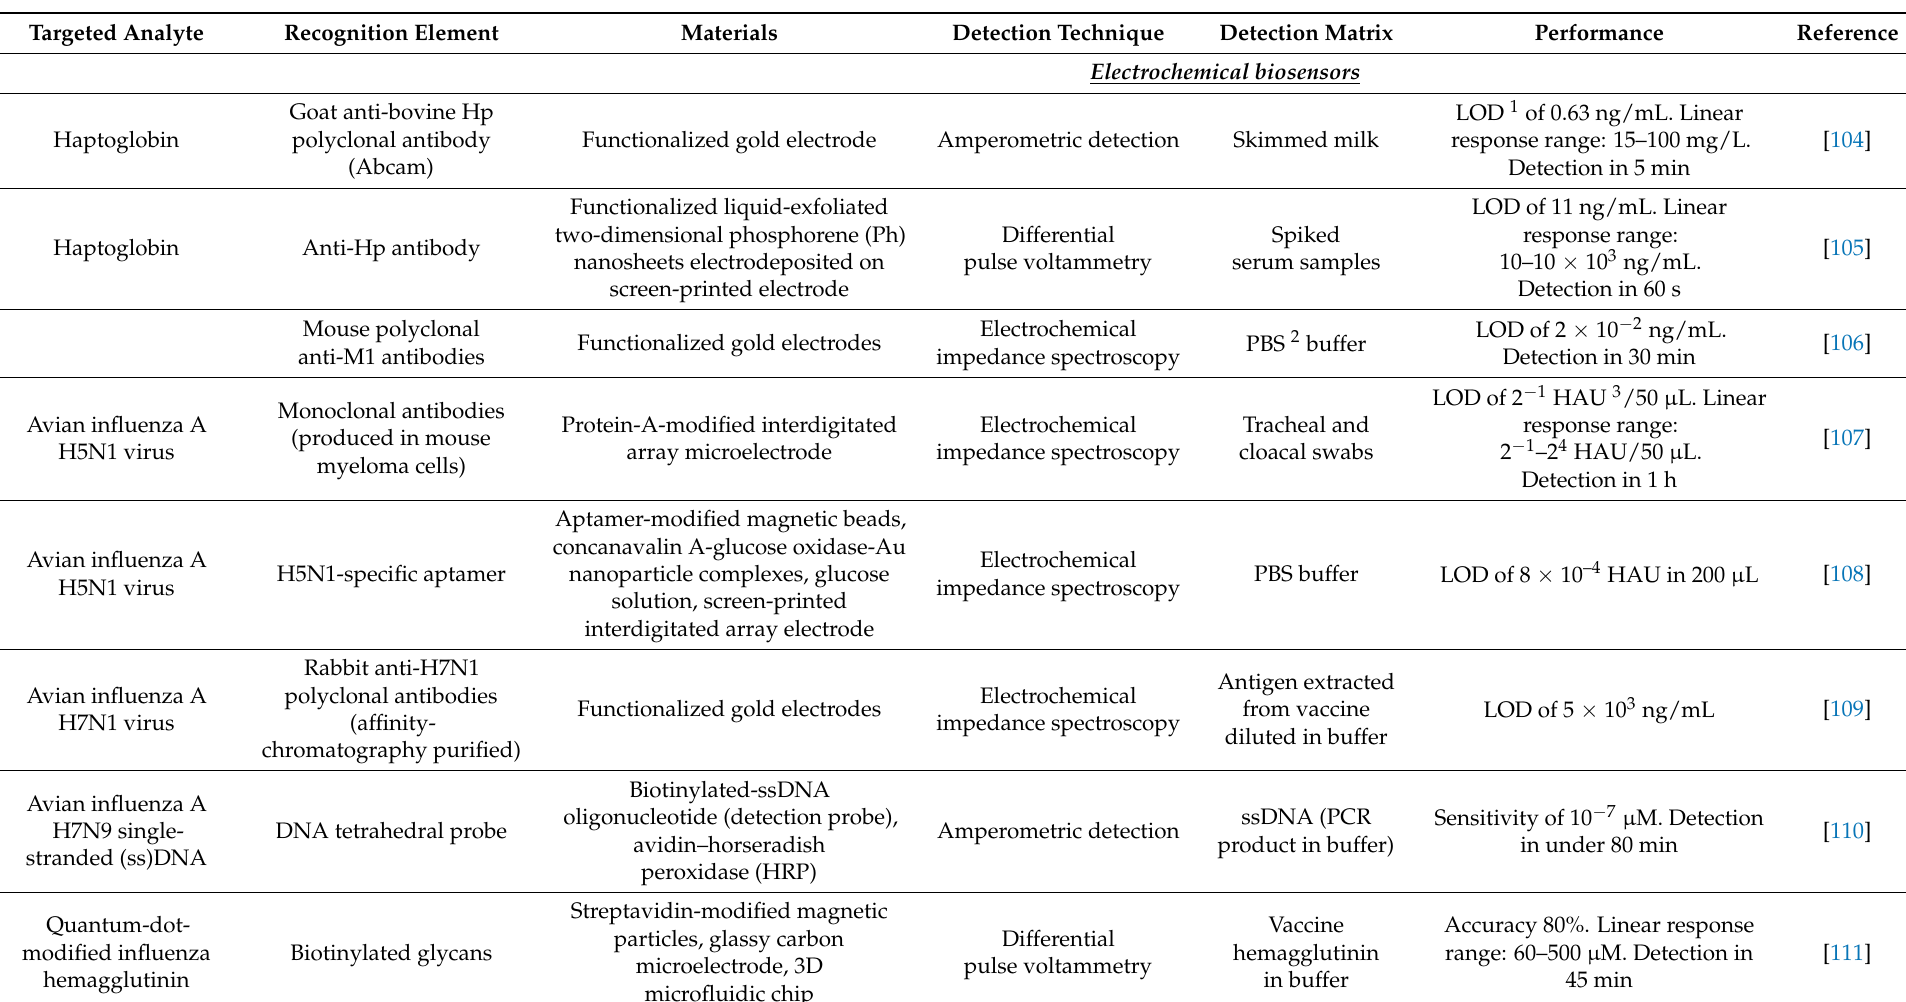
Table 1. Available electrochemical and optical biosensors for the detection of mastitis and animal diseases. The available literature for the remaining transducing options is included in the main